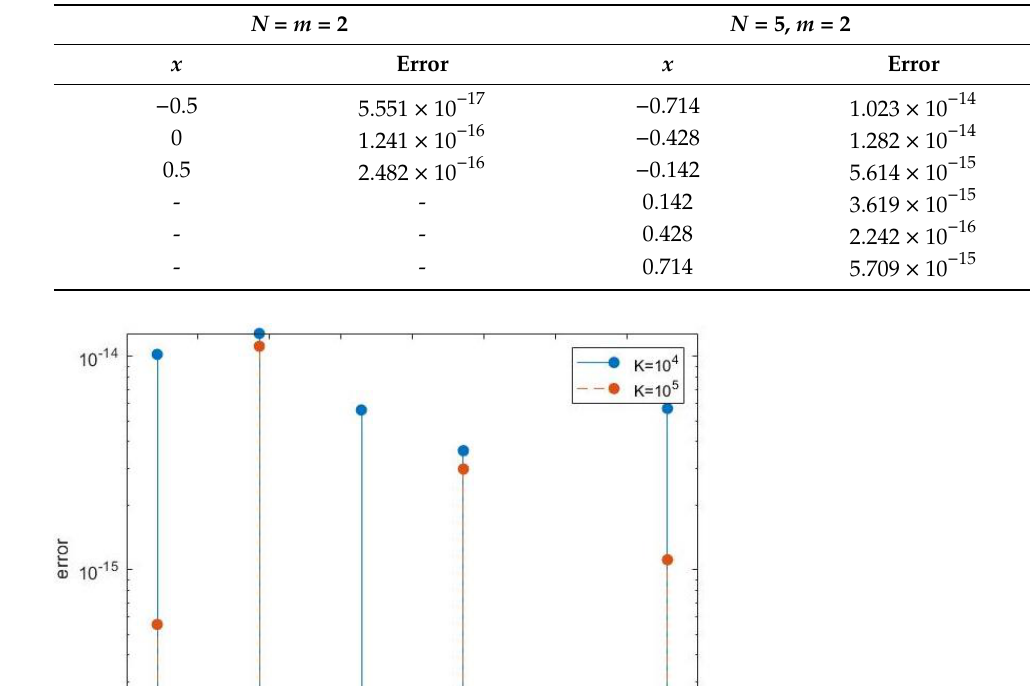
Table 3. The absolute error for k = 10 4 .